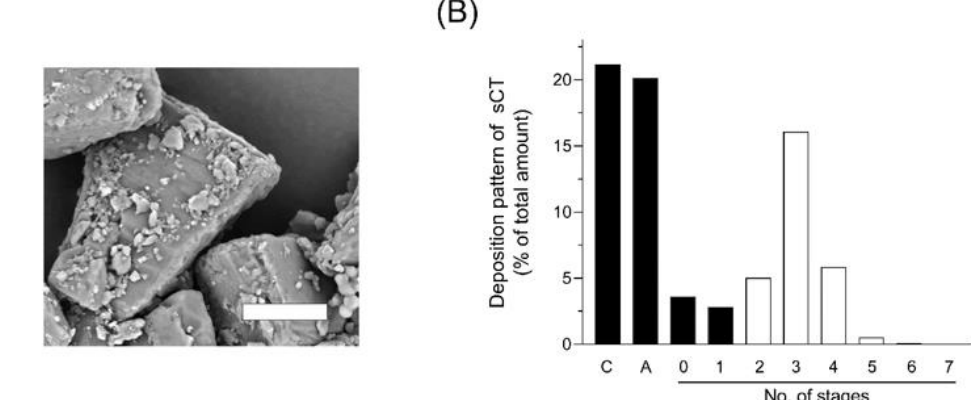
Figure 4. Appearance and in vitro inhalation property of sCT / SR-respirable powder (RP). ( A ) Scanning electron microscopic image of sCT / SR-RP. White bar represents 25 µ m. ( B ) Deposition pattern of sCT / SR-RP in Andersen cascade impactor (C, capsule; and A, adapter). The analysis was conducted using a Jet haler ® with an airflow rate of 28.3 L / min. The fine particle fraction (FPF) value of sCT / SR-RP was calculated using the ratio of total drug deposited in stage 2 and lower (white bars).